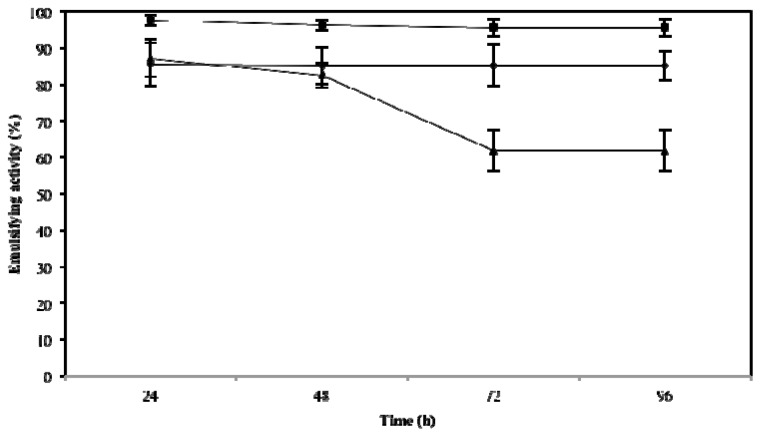
Emulsifying activity of microbactan on motor oil at different temperatures up to 96 h. 5 °C (●), 50 °C (■) and 100 °C (▲). Values represent means ± SD (n = 3).